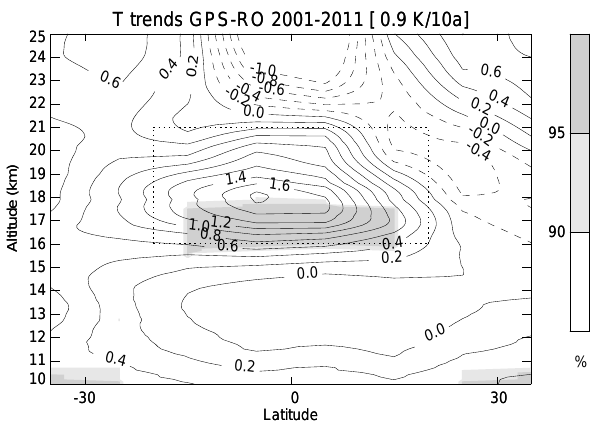
Figure 2. Latitude–height section of linear temperature trends over the past decade (2001–2011) from GPS-RO data over a height range from 10 to 25km and 35 ◦ S to 35 ◦ N latitude; contour interval is 0.2Kdecade − 1 . Grey shading represents the statistical significance for the trends.